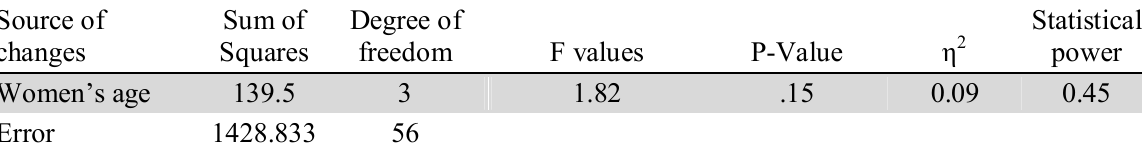
Source of changes